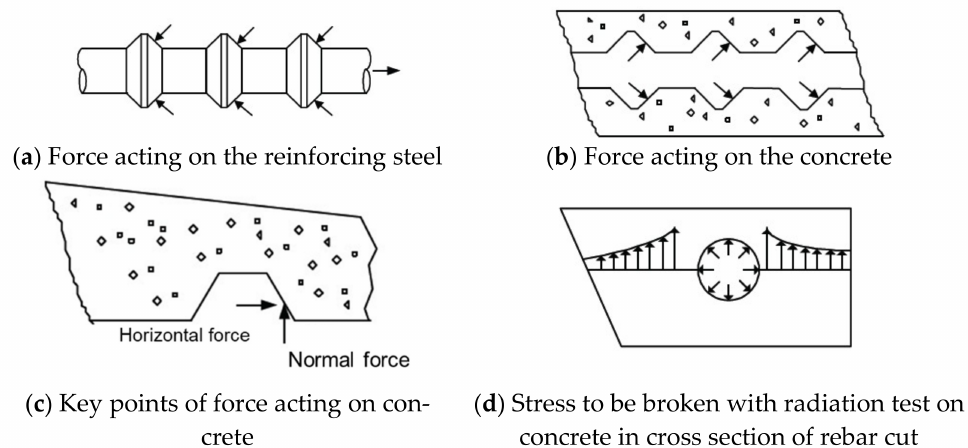
Figure 14. Reinforcement and concrete attachment